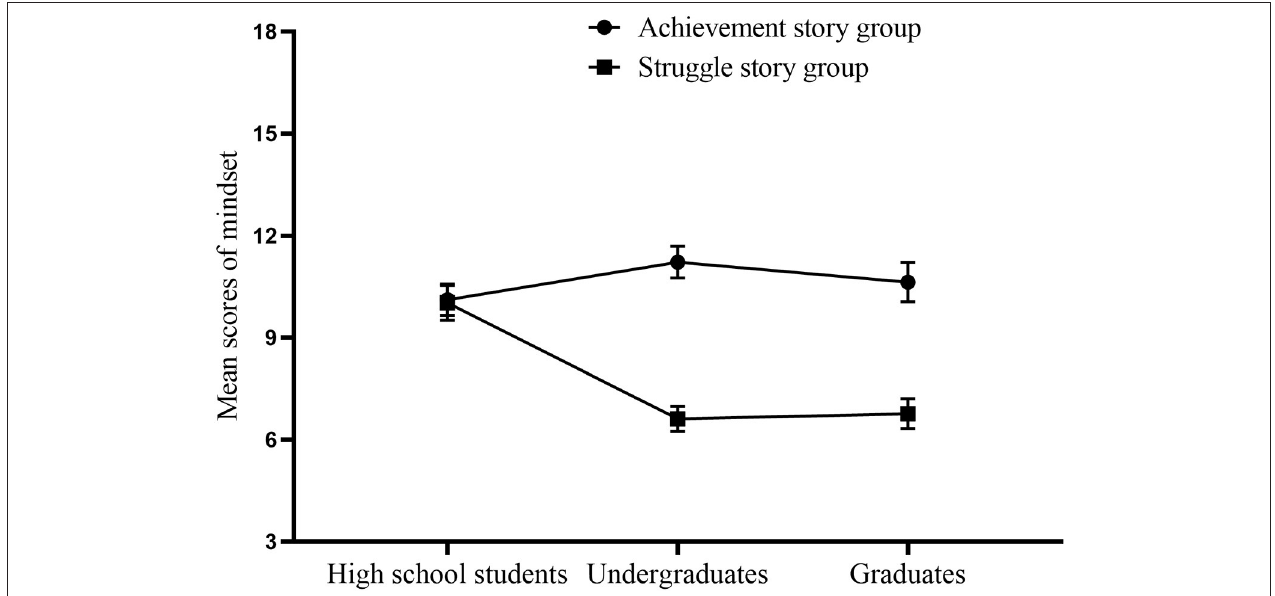
FIGURE 1 | The mindset scores of high school students, undergraduates, and graduates after reading struggle or achievement stories. Error bars represent standard error.